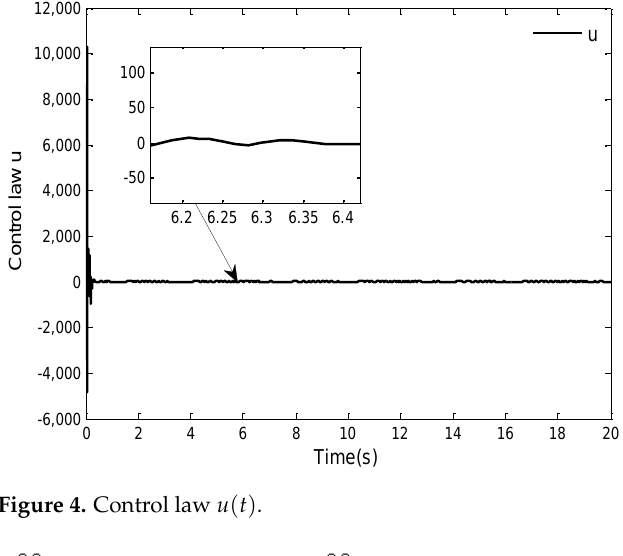
Figure 4. Control law u ( t ) .